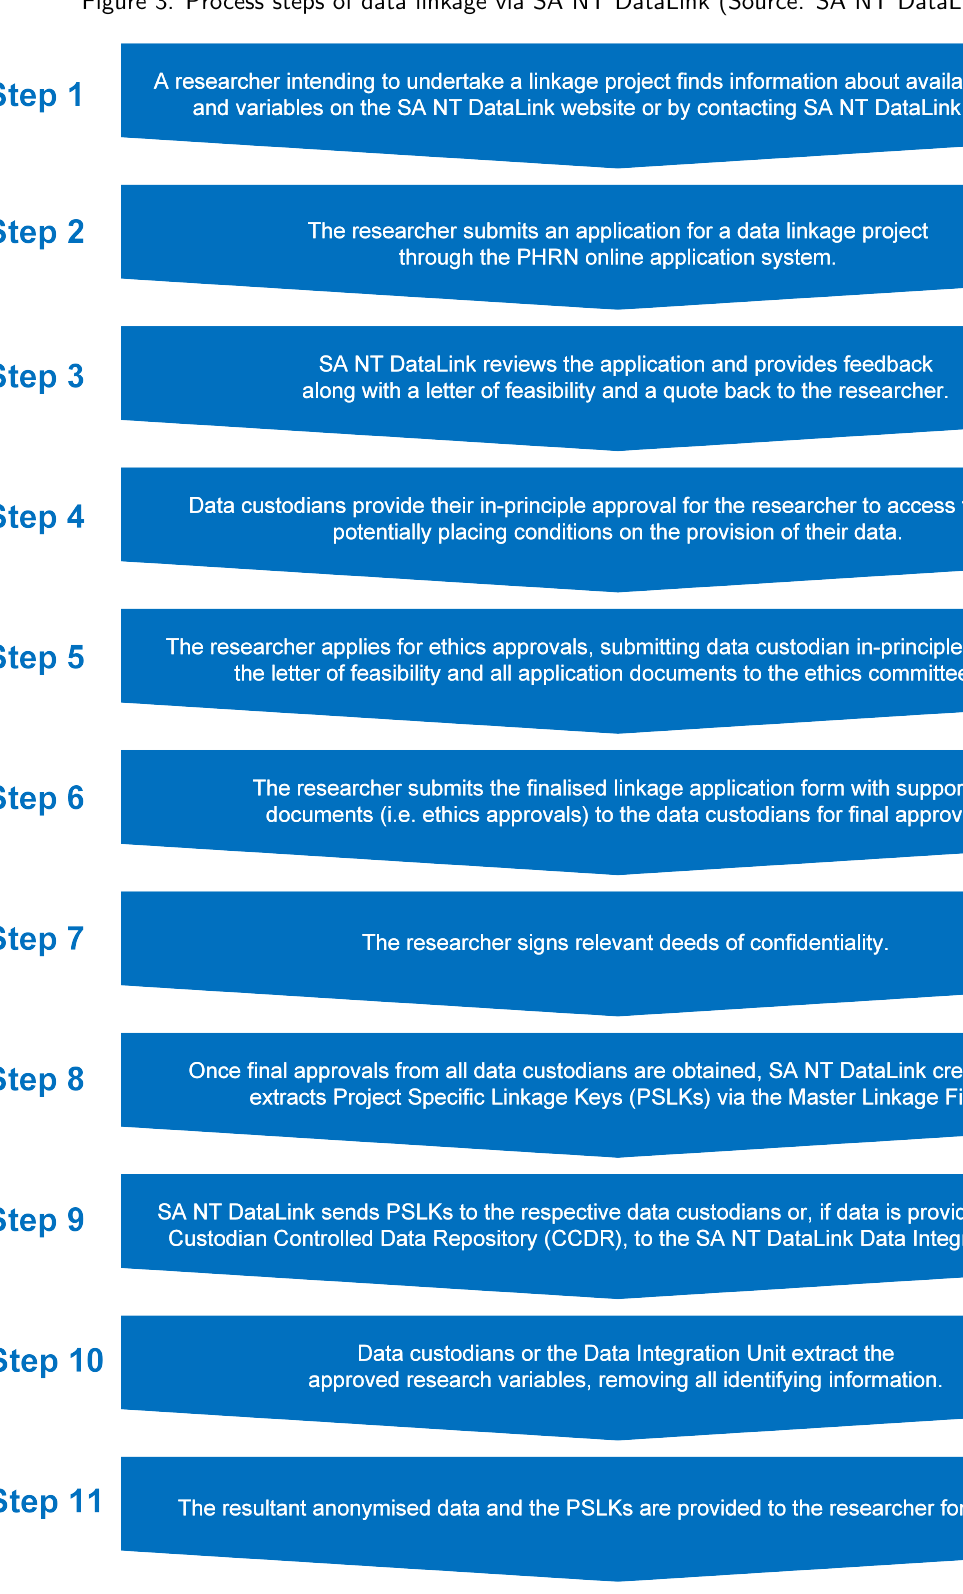
Figure 3: Process steps of data linkage via SA NT DataLink (Source: SA NT